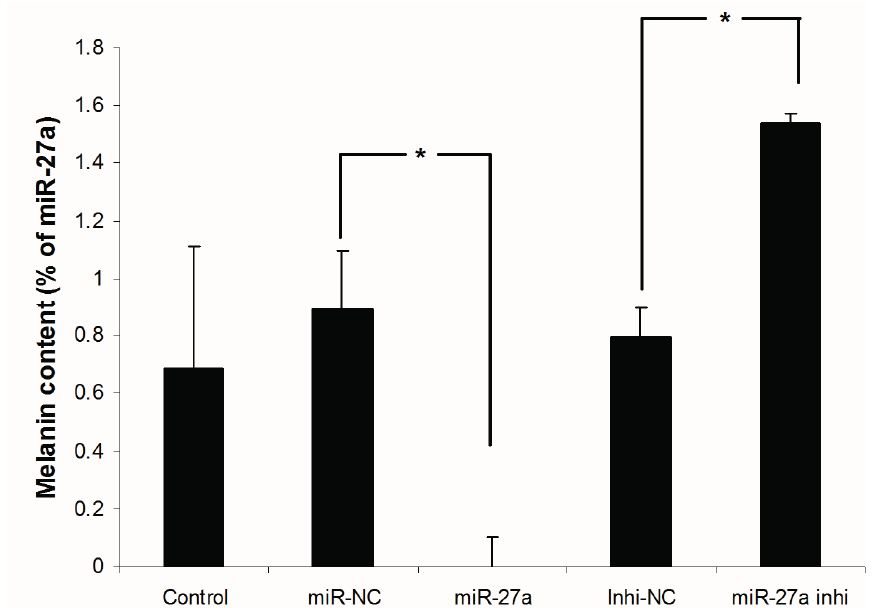
Figure 6. Melanin contents in melanocytes transfected with miR-27a mimic or inhibitor as well as their controls. Treated cells were divided into 5 groups: miR-NC, miR-27a, Inhi-NC, miR-27a inhi and untransfected control. MiR-27a groups are reference as 0. Values represent the mean ± SE from four independent experiments. * p <